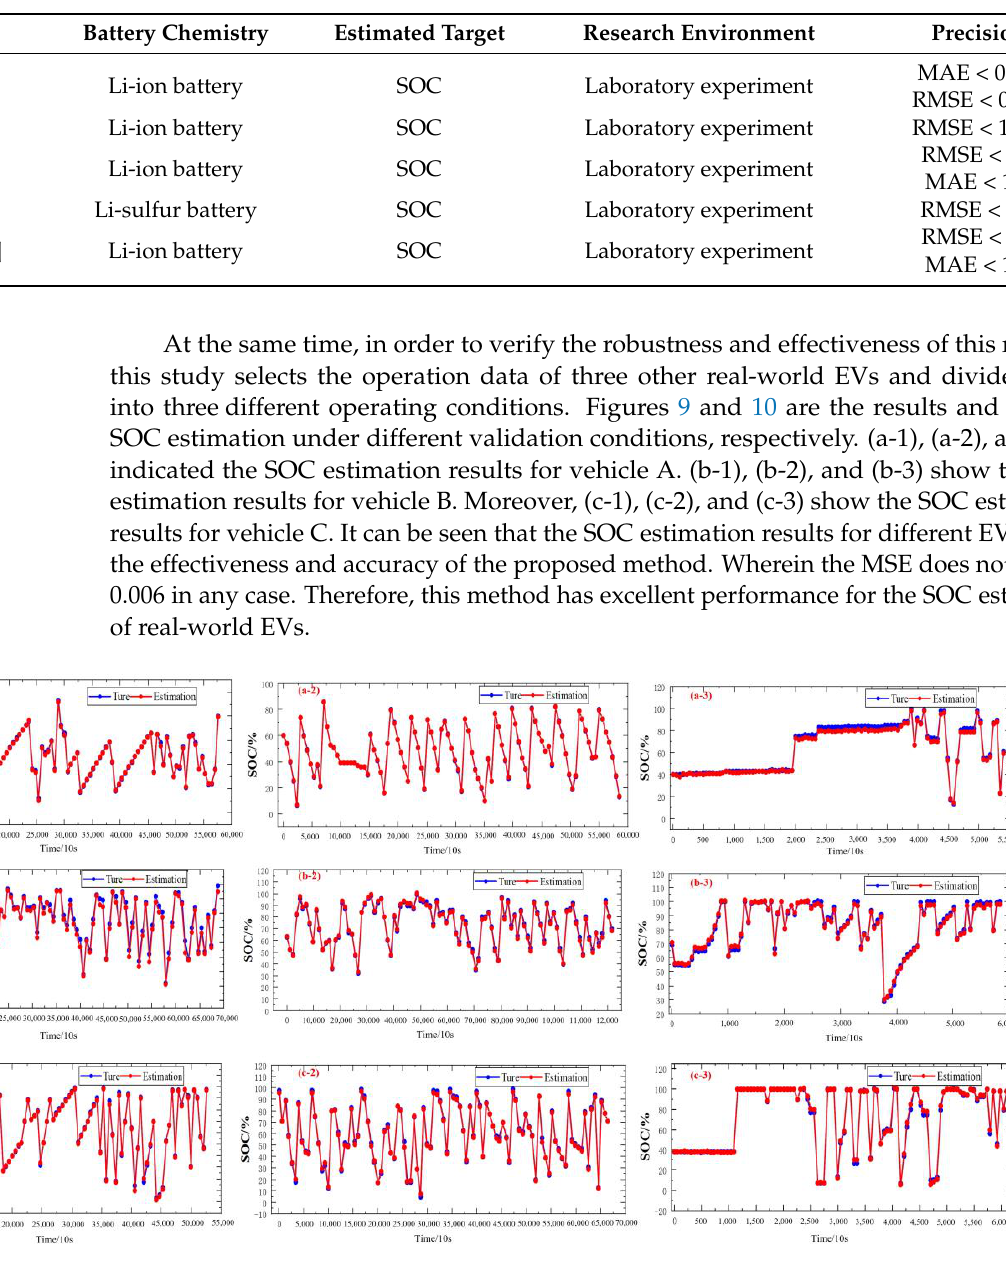
Figure 10. MSEs of SOC estimation results under different validation cases. 5. Conclusions Battery SOC is one of the main parameters for the battery management system, but its inability to be measured directly poses a great challenge for the real-world electric ve- hicle. Currently, most SOC estimation methods are still in the laboratory stage. Therefore, it is critical to investigate the SOC estimation methods for real-world electric vehicles. This paper indicates a novel grid search and cross-validation optimised long and short-term memory network hyperparameter approach to conduct battery SOC estimation based on real-world electric vehicle data. The results showed that optimised hyperparameters of the long and short-term memory networks could achieve a high accuracy of SOC estima- tion with an absolute error of SOC estimation of less than 4%. Wherein the absolute error accuracy of SOC estimation is less than 2% under the conditions of the large dataset.